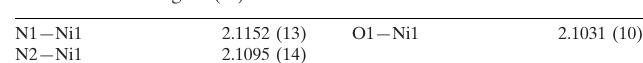
Selected bond lengths (A˚ ).